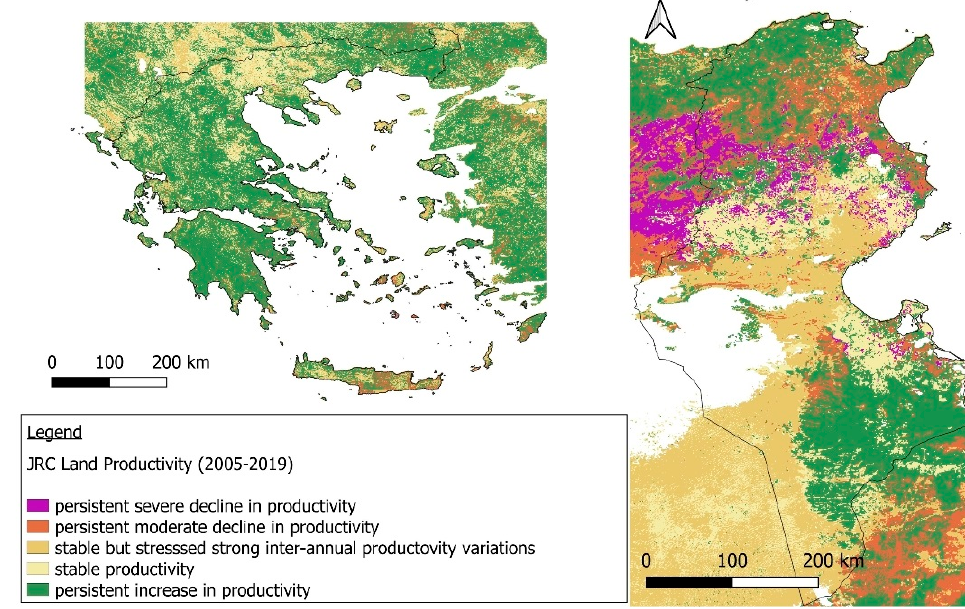
Figure 8. Spatial distribution of JRC land productivity in 2005–2019 in Greece ( left ) and Tunisia ( right ).